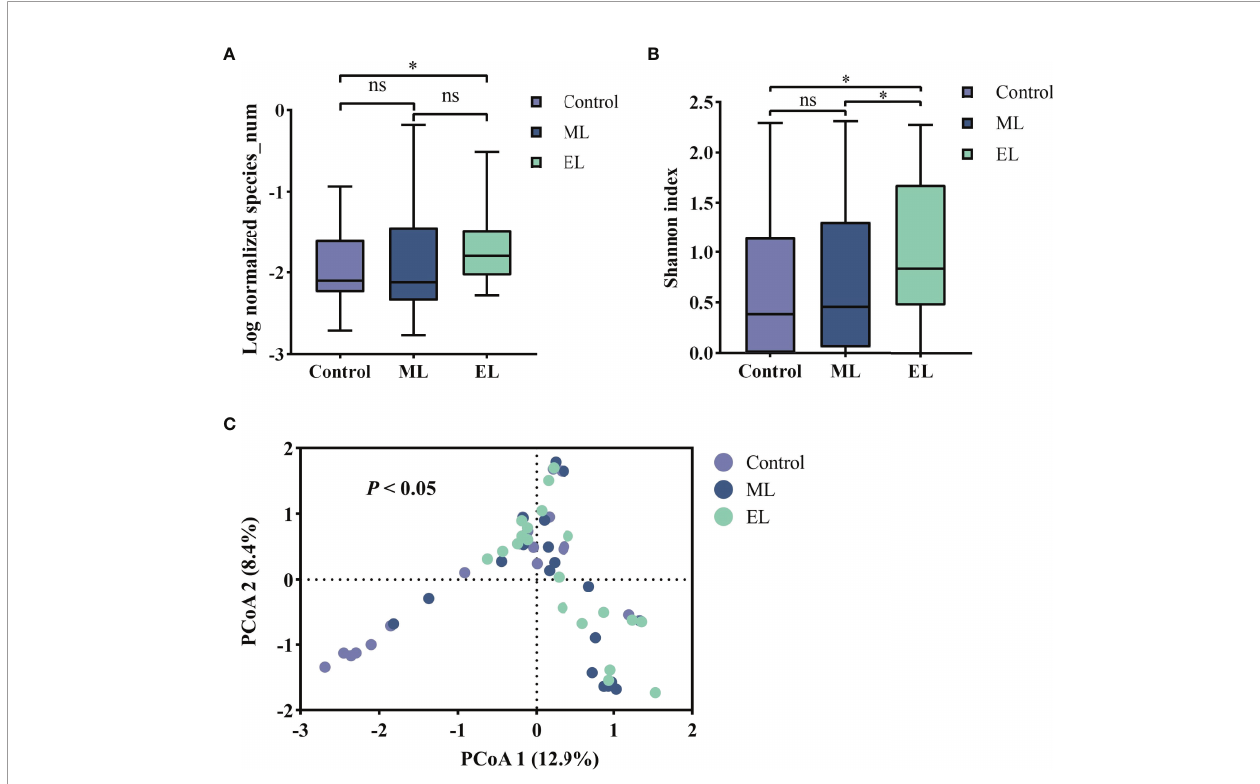
FIGURE 4 | The microbial diversity of the three DNA extraction methods. Median values are indicated by the line within the boxplot. The box extends from the 25th to 75th percentiles, and whiskers indicate the minimum and maximum values. * P < 0.05; ns, nonsigni fi cant. (A) Log normalized total number of microbial species observed by mNGS. (B) Alpha diversity based on the Shannon index. (C) Beta diversity with PCoA based on the Bray – Curtis index.